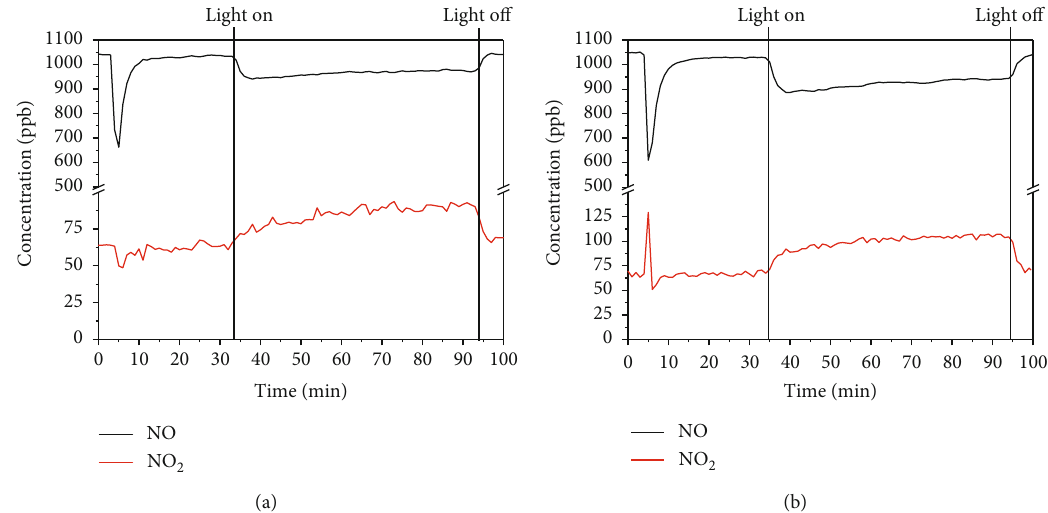
Figure 4: NO and NO concentration during the test according to ISO 22197:1 2007 for (a) 10TEOS-5TiO 2